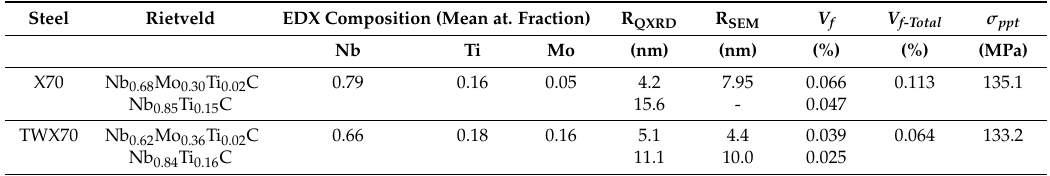
Table 6. Summary of Rietveld refinement and SEM-EDX analysis for nano-sized precipitates.